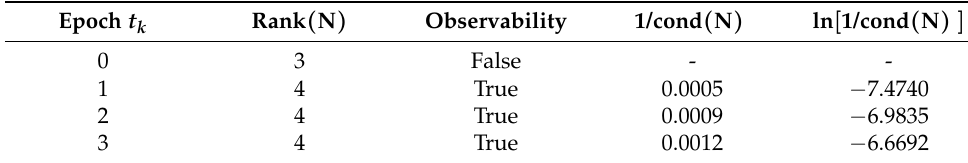
Table 2. Observability test results of case I (nonperturbation).